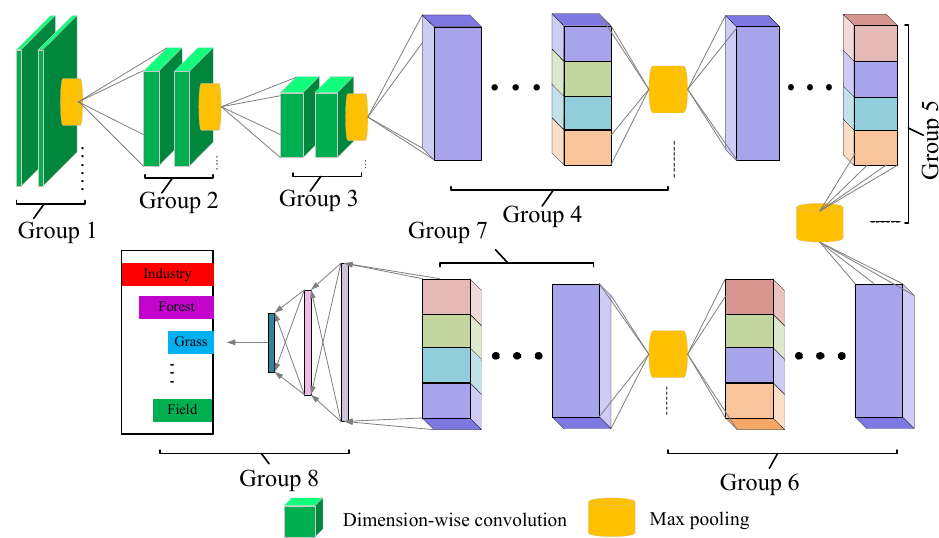
Figure 3. The overall structure of the proposed LCNN-HWCF method.